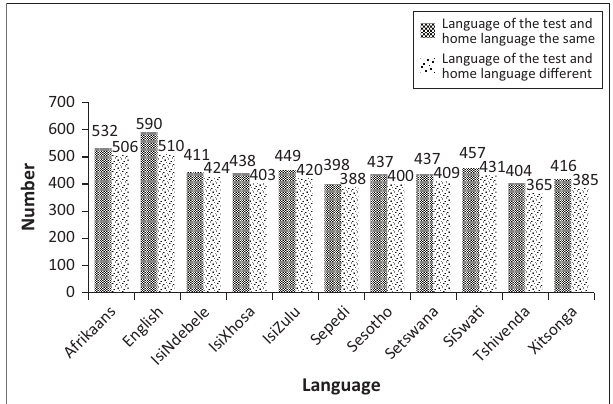
FIGURE 1: South African Grade 4 student performance by test language in the same or different language to their home language.